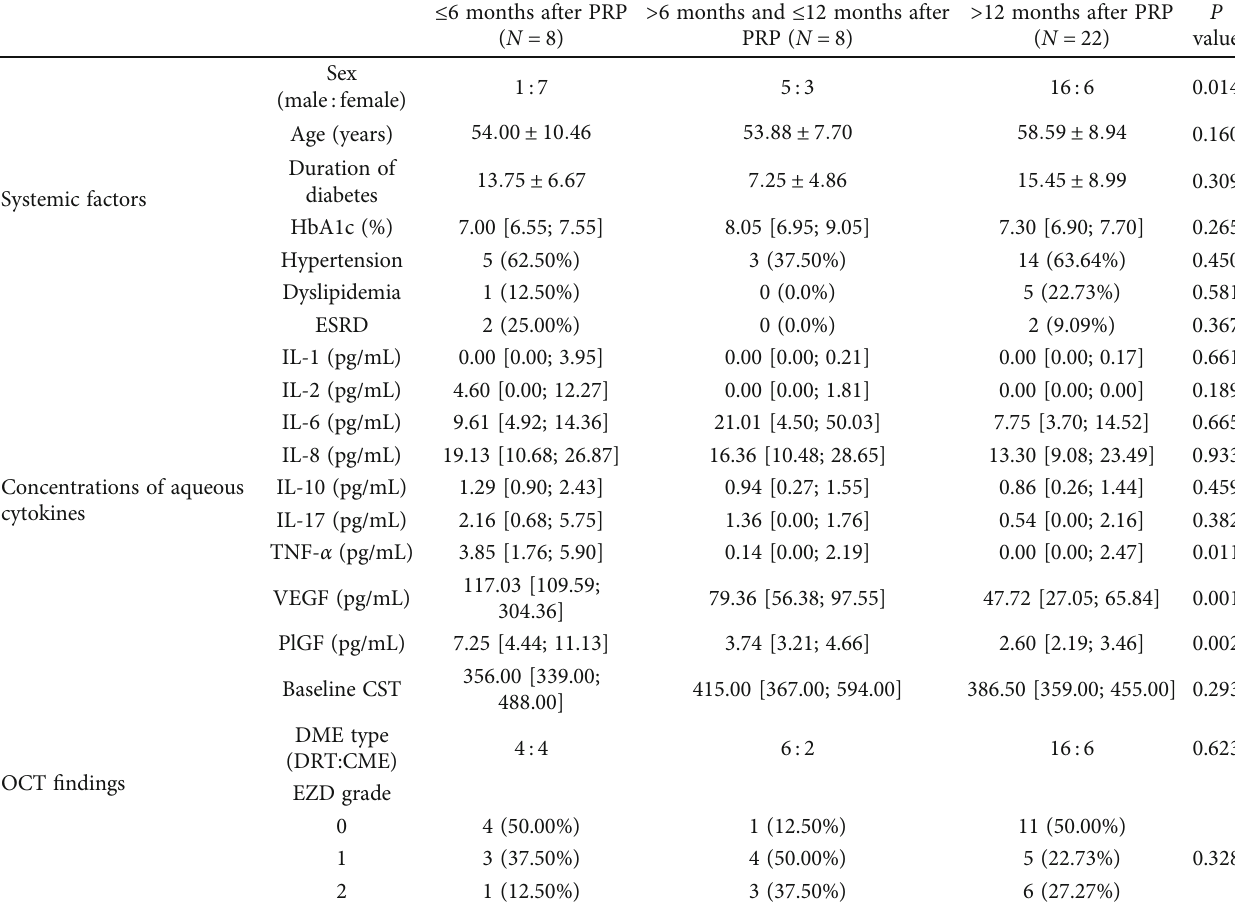
Table 2: Characteristics of patients depending on interval between PRP and aqueous